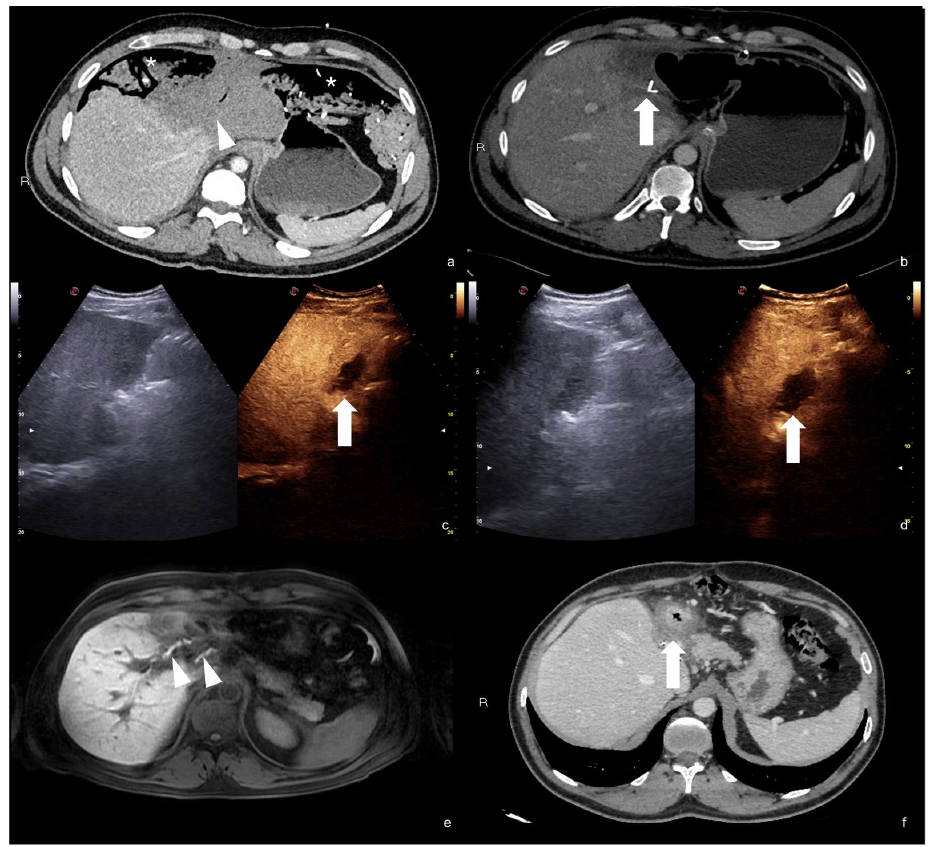
Figure 27. Post-traumatic laceration of the left hepatic lobe ( a , white arrowhead) with evidence of surgical packing (asterisk); after surgical lobectomy, contrast-enhanced CT scan ( b ) showed a small fluid collection close to the biliary duct clipping (white arrow). Such collection increased in volume at follow-up CEUS examinations ( c , d , respectively, 2 and 3 weeks after surgery, white arrows); this finding indirectly suggested a possible biliary leakage, although not directly viewable at CEUS ( c , d , white arrows). This finding was confirmed at post-contrast hepatospecific phase fat-sat T1w MRI examination that showed biliary leak ( e , arrowheads). Subsequent exclusion of the biliary leak with complete reabsorption of the biliary collection at CT examination ( f ,